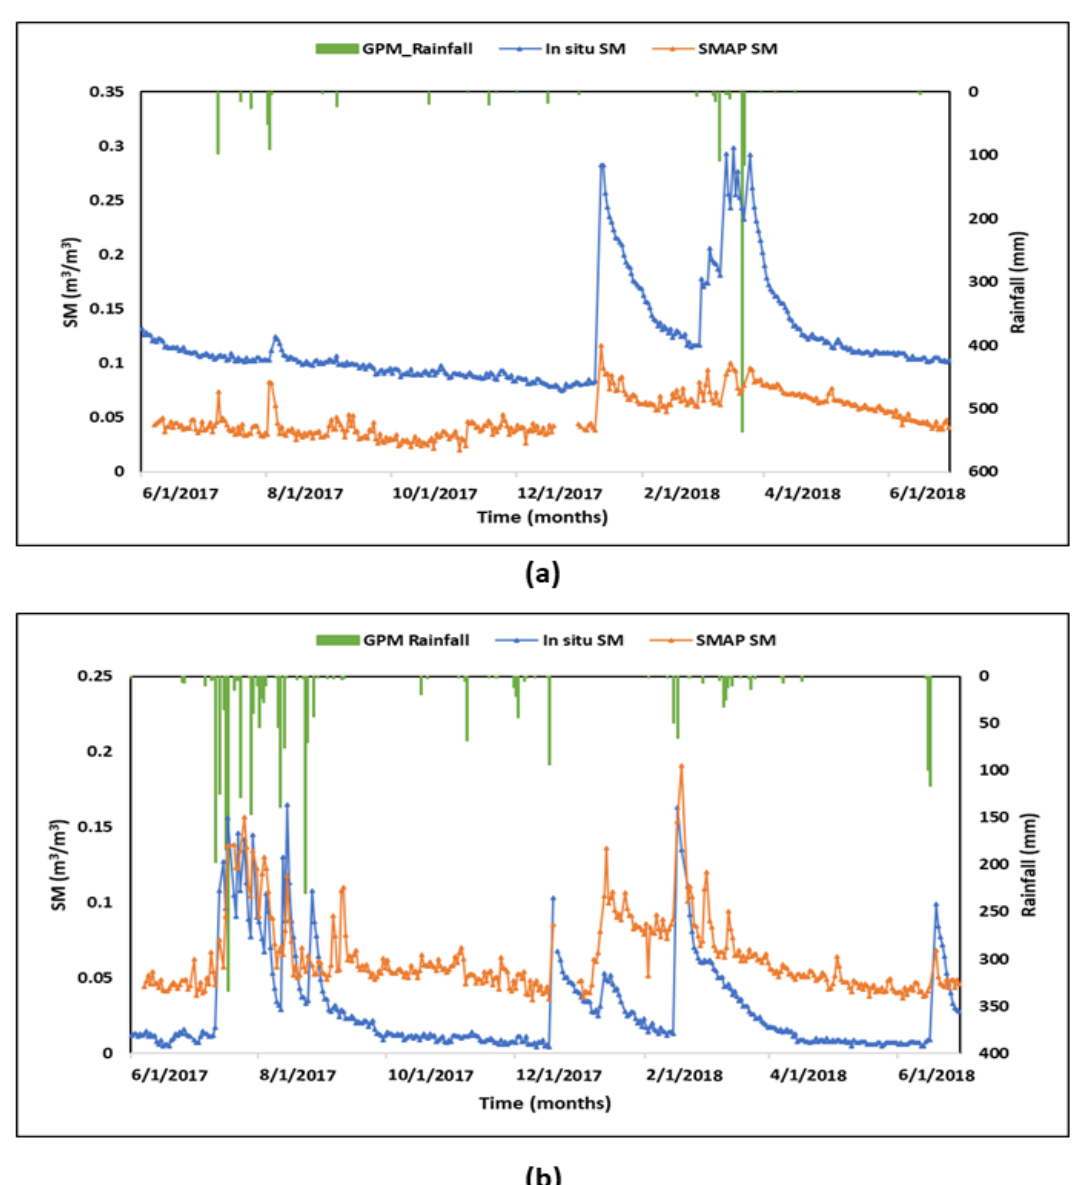
Figure 3. Temporal series plot between the SMAP SM, in situ SM and GPM rainfall for ( a ) Fallbrook, California and ( b ) Tucson, Arizona, North America.